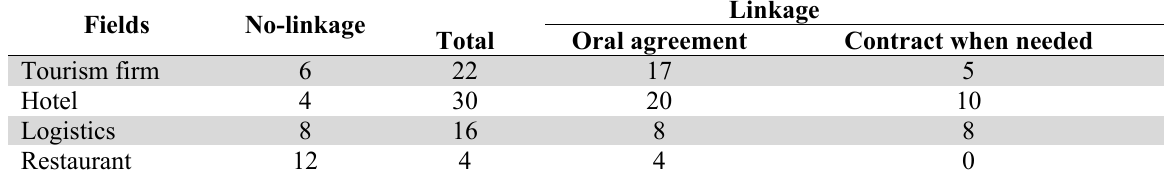
Situation of Horizontal Linkages of Tourism Firms (Unit: No. of firms) Linkage Fields No-linkage Total Oral agreement Contract when needed 6 22 17 5 4 30 20 10 8 16 8